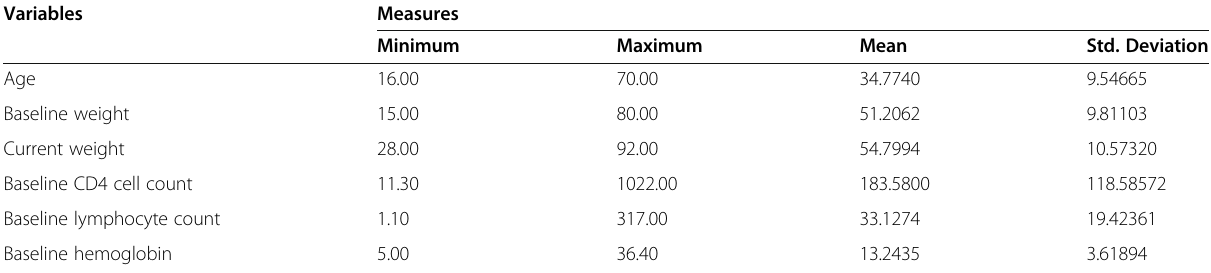
Table 3 Description of continuous covariates/measures of 354 HIV/AIDS patients under the study (University of Gondar teaching hospital, 2009 –